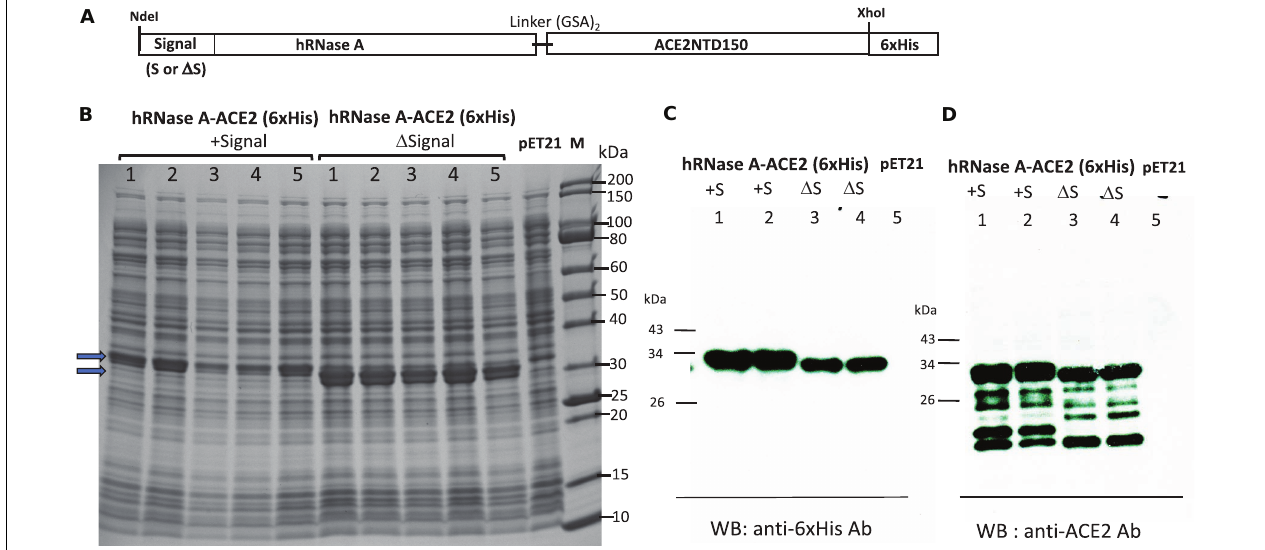
Frontiers in Microbiology |